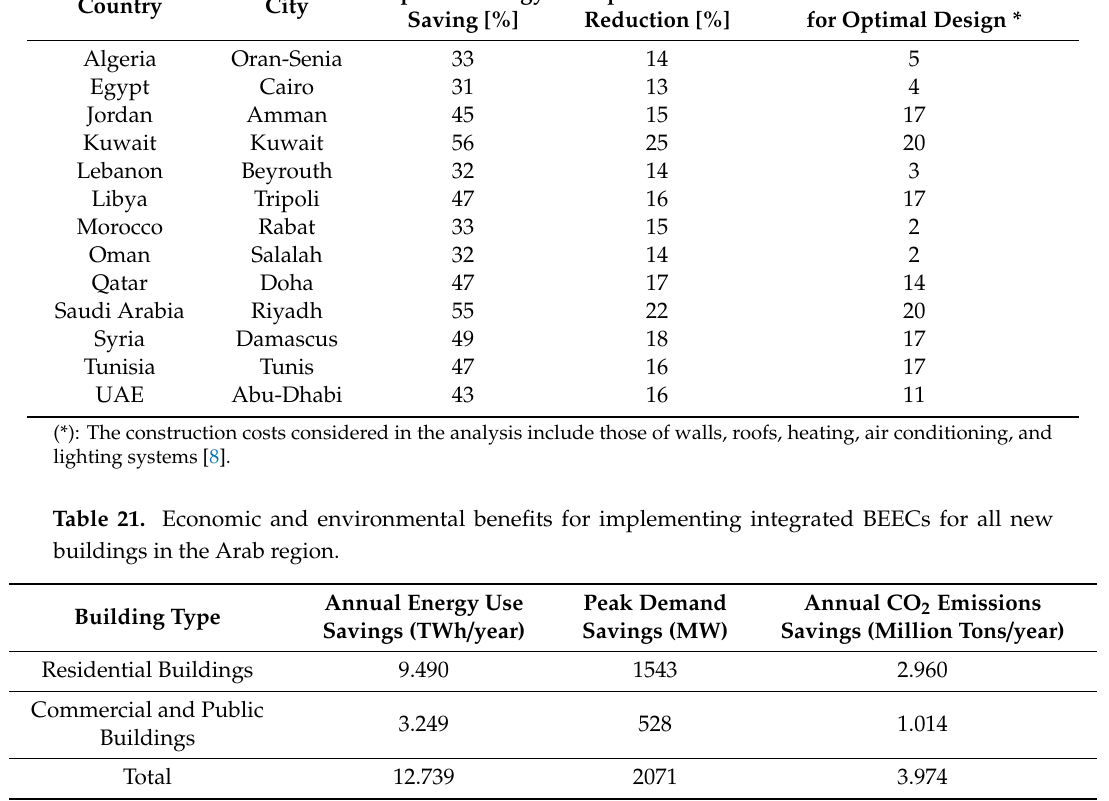
Table 20. Summary of energy use savings and normalized life-cycle cost (LCC) values and implementation costs for minimizing LCC to achieve optimal designs for residential buildings in select Arab cities. Country City Saving [%]